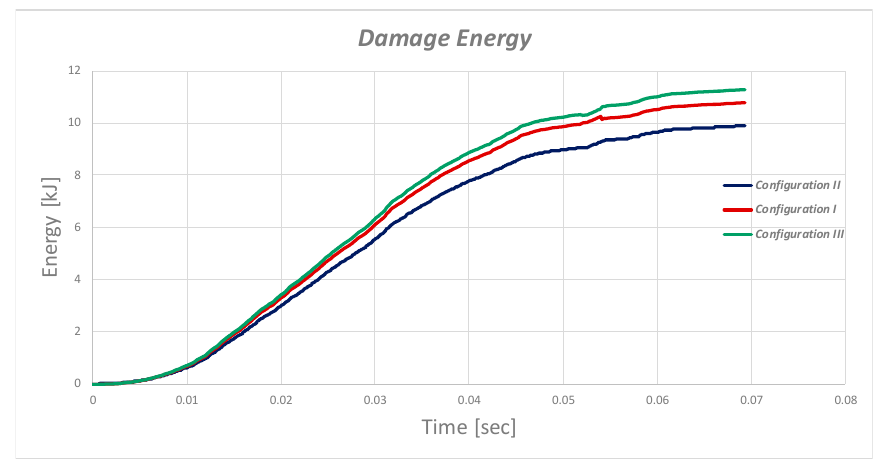
Figure 11. Damage energy dissipation.